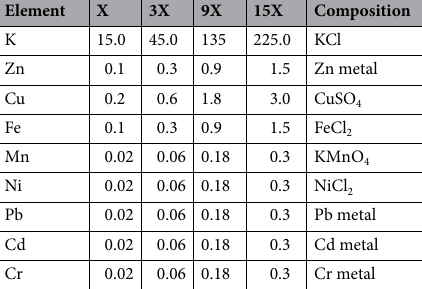
Table 2. Simulated heavy metal concentration in irrigation water